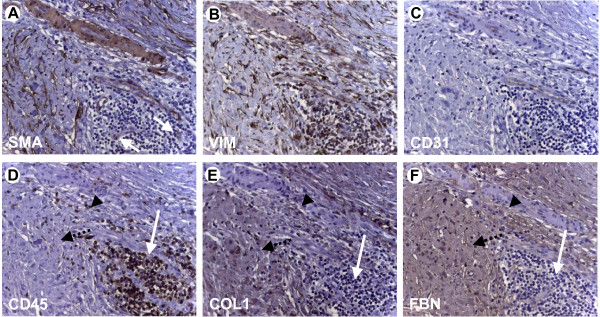
Details of immunohistochemical analysis of chronic pancreatitis tissues. (A&B) Pancreatic stellate cells are seen within clusters of mononuclear cell infiltration. (A) Arrows: stellate cells. (C) To exclude that alphaSMA- (SMA) and vimentin-positive (VIM) structures are endothelia, CD31 staining was performed. (D-F) In areas of loosely packed mononuclear cells (arrowhead in D) and packed mononuclear cells (white arrow in D), there is sparse immunoreactivity for collagen1 (arrowhead and white arrow in E) and moderate staining for fibronectin (arrowhead and white arrow in F). In areas with a low number of CD45-positive mononuclear cells (dotted arrow in D), the staining intensities for collagen1 (dotted arrow in E; COL) and fibronectin (dotted arrow in F; FBN) are stronger. Original magnification: ×200.